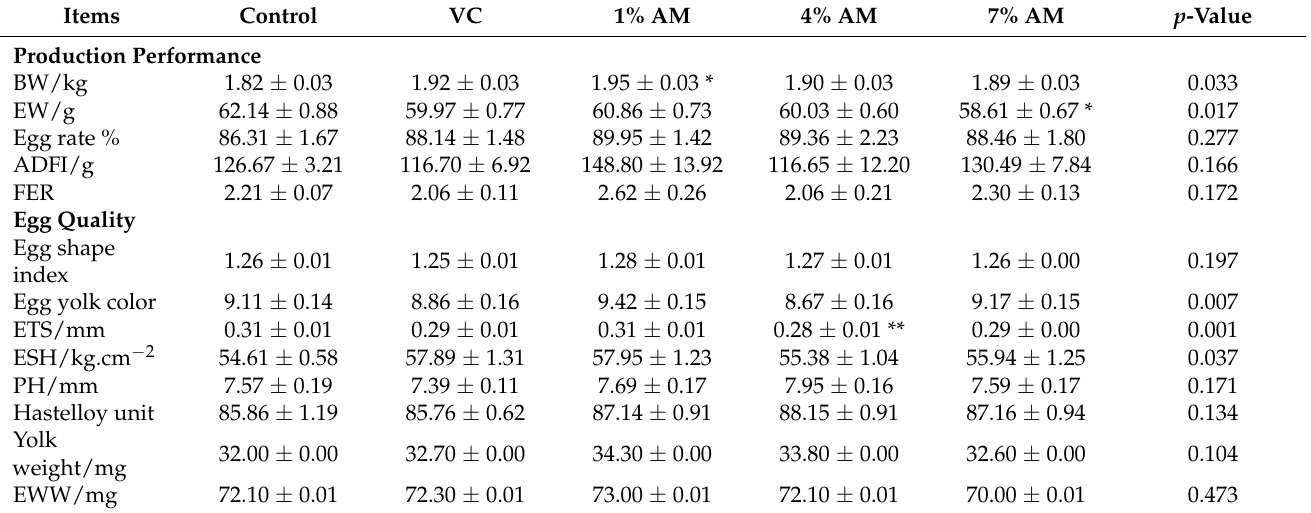
Table 4. Effects of AM on production performance and egg quality of laying